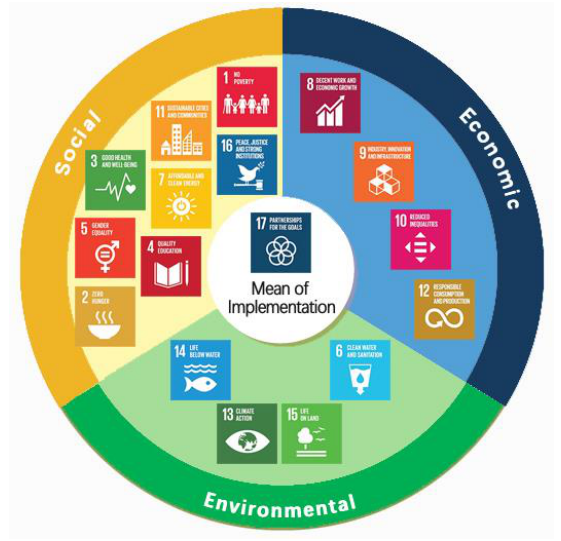
Figure 1. SGDs Structures